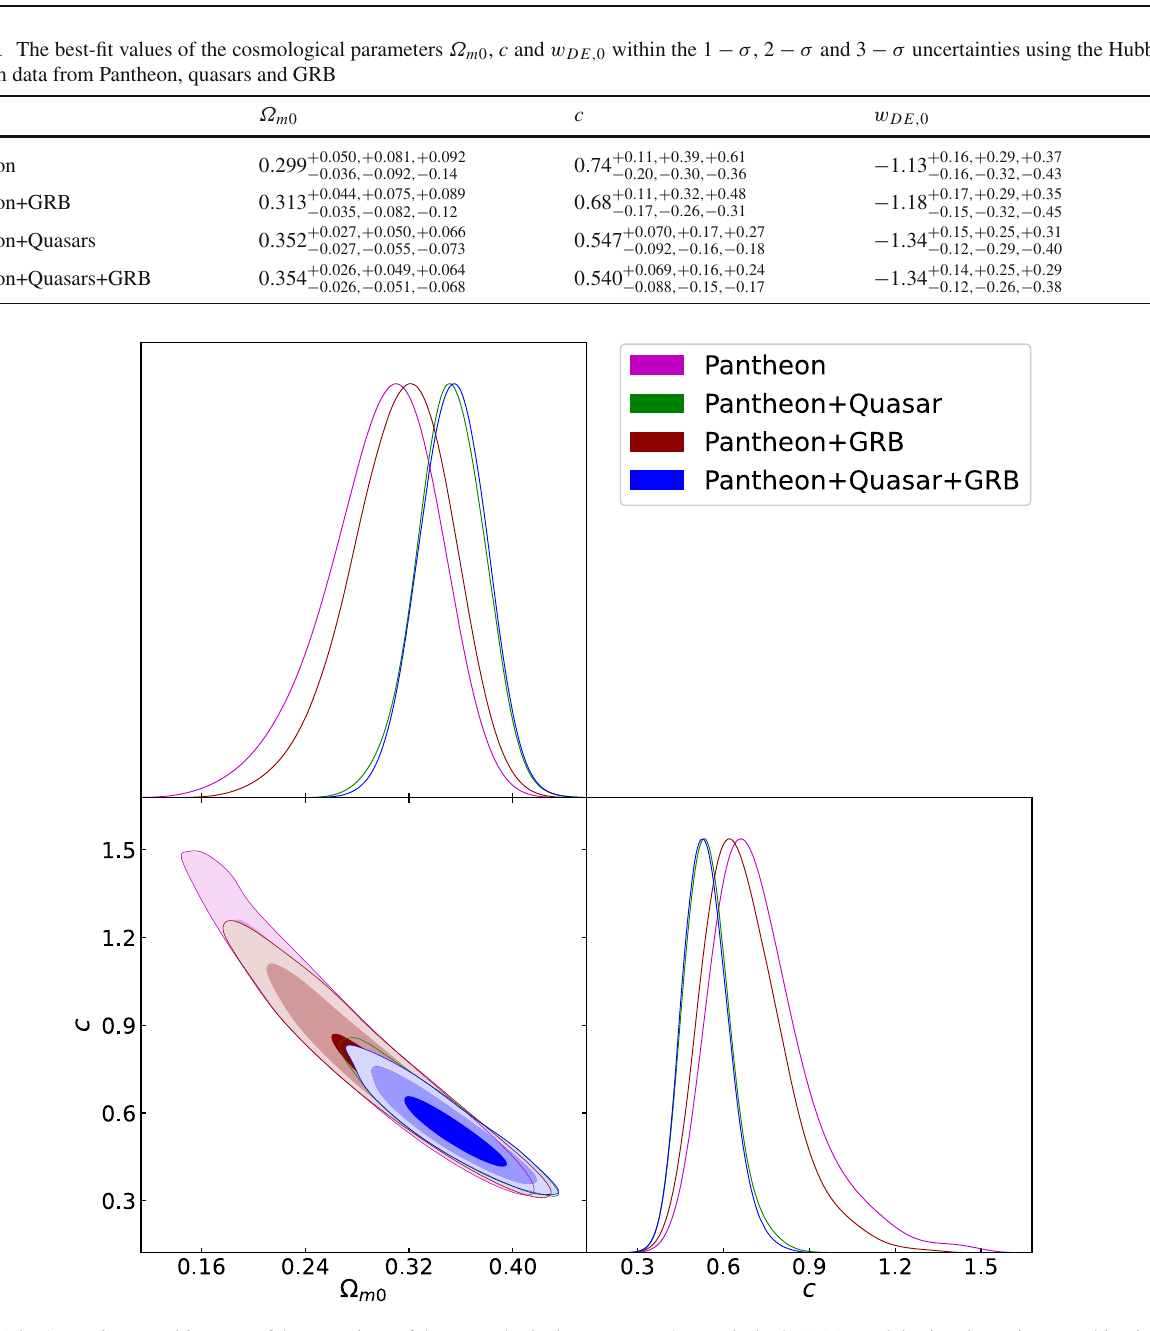
Fig. 1 The 1 − σ , 2 − σ and 3 − σ confidence regions of the cosmological parameters Ω m 0 and c in the HDE model using the various combinations of the Hubble diagram data from Pantheon, quasars and